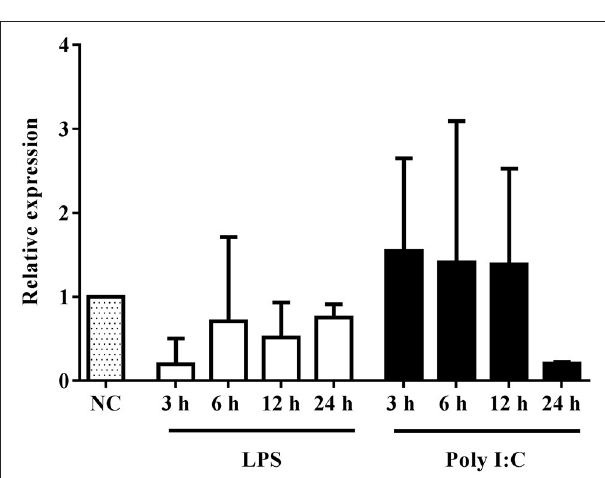
FIGURE 3 | Expression of BlTLR gene after LPS or Poly I:C treatment. Animals previously immersed in 10 µ g/ml LPS or 10 µ g/ml Poly I:C, were collected at 3, 6, 12 and 24h. The untreated animals were used as a control and assigned a value of 1 in the histogram. GAPDH was used as a reference gene. The bars indicate mean expression of 3 individual animals ± S.D. Significant differences of mean values were analyzed according to one-way ANOVA followed by Tukey’s